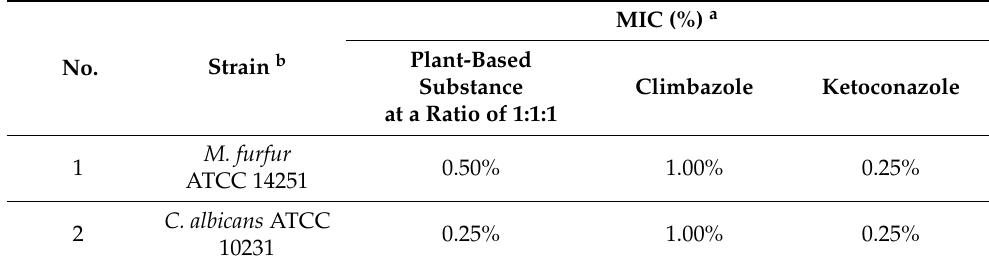
Table 5. MICs of substances against several fungal strains involved in the pathogenesis of SD. No. Strain b